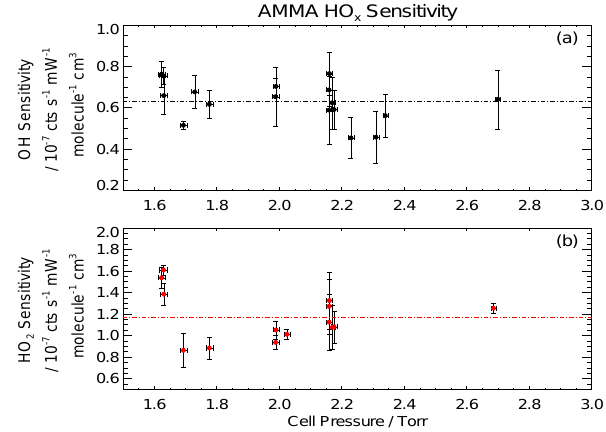
Fig. 5. Multipoint calibration for OH and HO 2 at a constant wa- ter vapour (332ppmv). Calibrations were conducted for a range of water vapour mixing ratios between 10000ppmv and 332ppmv. The lamp current was varied to produce a range of OH and HO 2 concentrations from 1 × 10 7 to 1.7 × 10 8 moleculecm − 3 . Error bars indicate the standard deviation of the data within each data point.